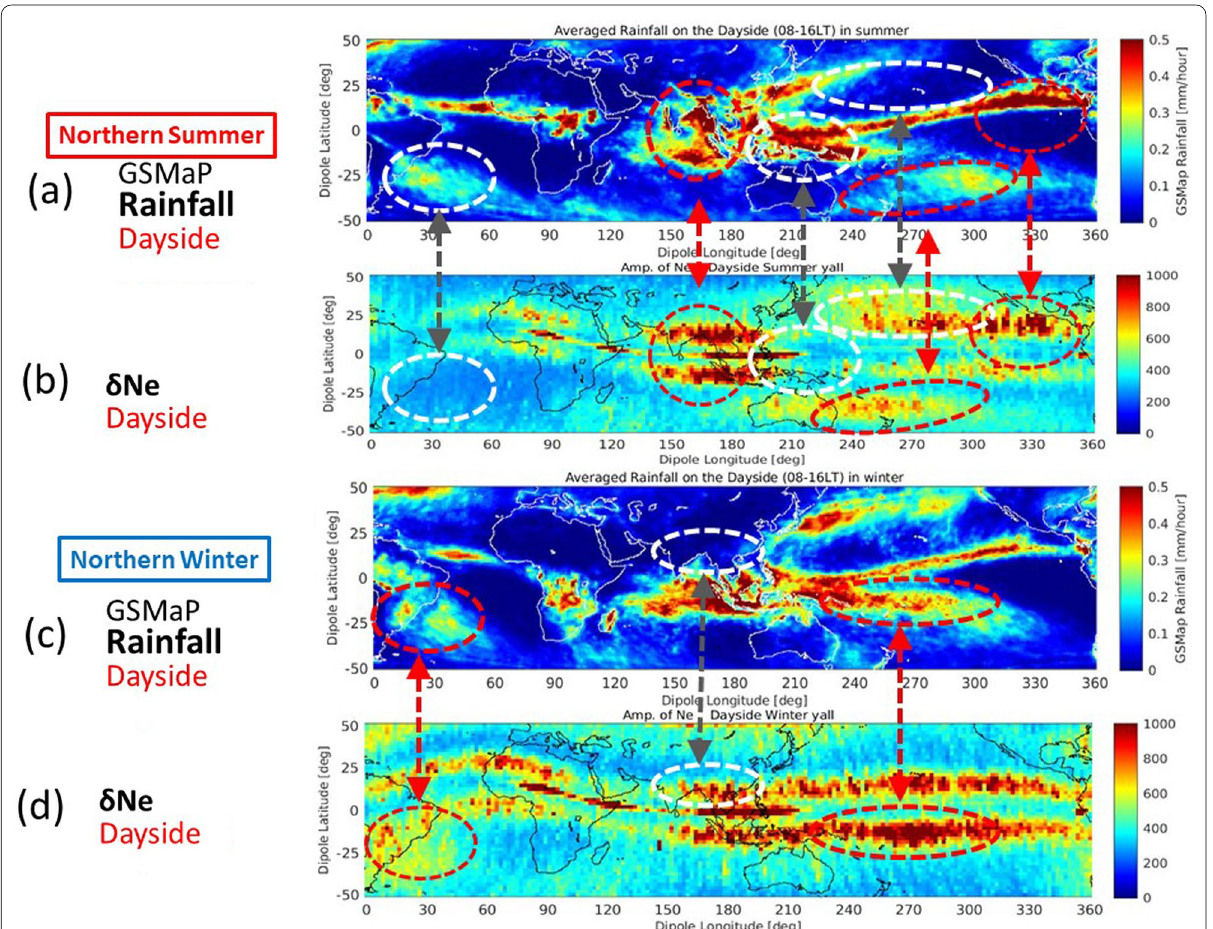
Fig. 4 a Global distribution of rainfall estimated by GSMaP for June solstice (May–July), b Amplitude distribution of electron density fluctuations observed by the Swarm satellite, c and d Same as a and b but for December solstice